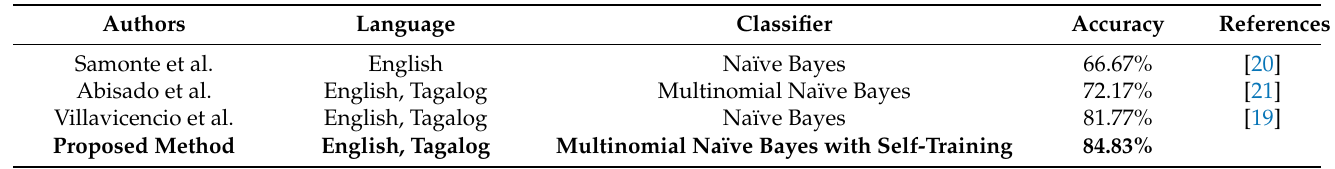
Table 1. Comparison of Philippine Tweet classification